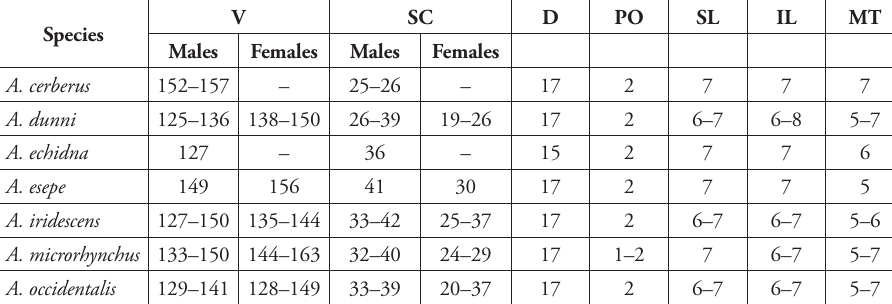
Table 2. Morphometric data for members of the Atractus iridescens species group. Codes are: V=ventrals; SC=subcaudals; D=dorsal scale rows at midbody; PO=postoculars; SL=supralabials; IL=infralabials; MT=maxillary teeth. Data is derived from Appendix III and from the